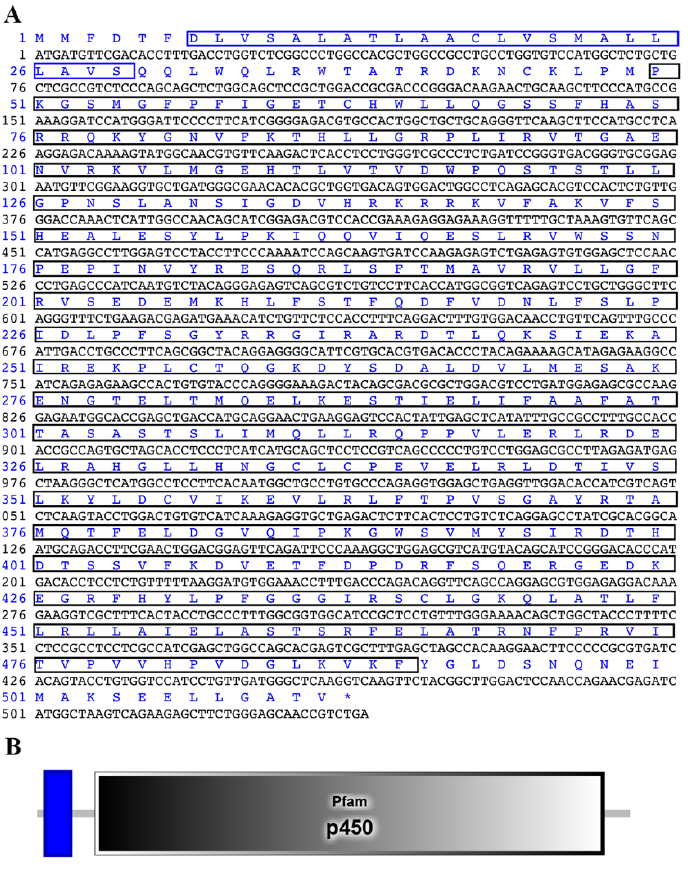
Figure 1. The cyp26b1 (GenBank accession number: XM_008324250.3) ORF and its domains in Chinese tongue sole. ( A ), Nucleotide and the derived pattern of cyp26b1 . The initiated codon is ATG and stop codon is TGA. The blue boxs represent transmembrane regions and black boxes represent Pfam: p450 domain. ( B ), Domains of cyp26b1 predicted by SMART program. The transmembrane region is shown with a blue box. The Pfam: p450 domain was marked with gray box.